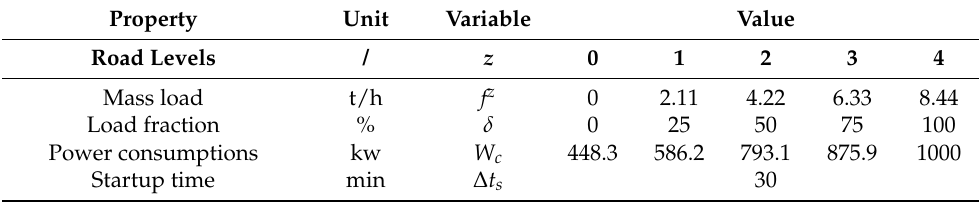
Table 7. Operating characteristic of BOG